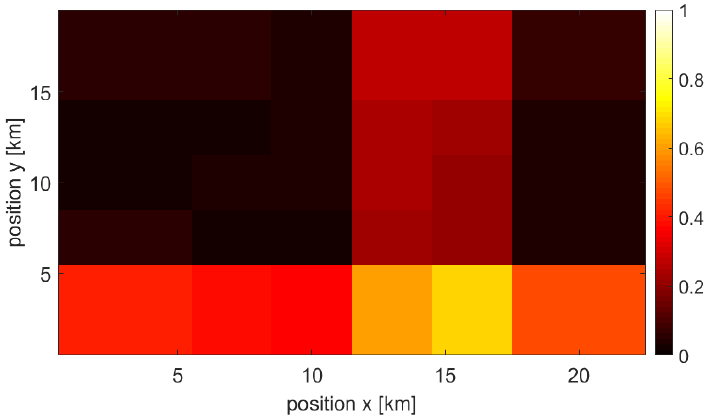
Figure 2. Example of a user density map created by data from access points.